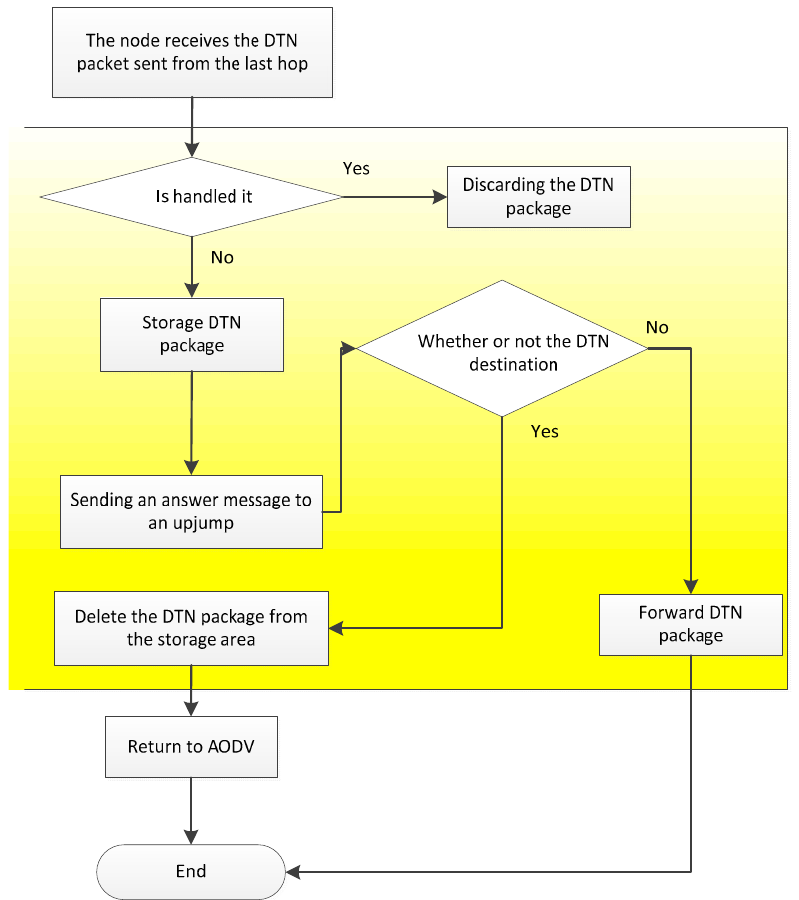
Figure 9. Receiving of the processing of the DTN package process.